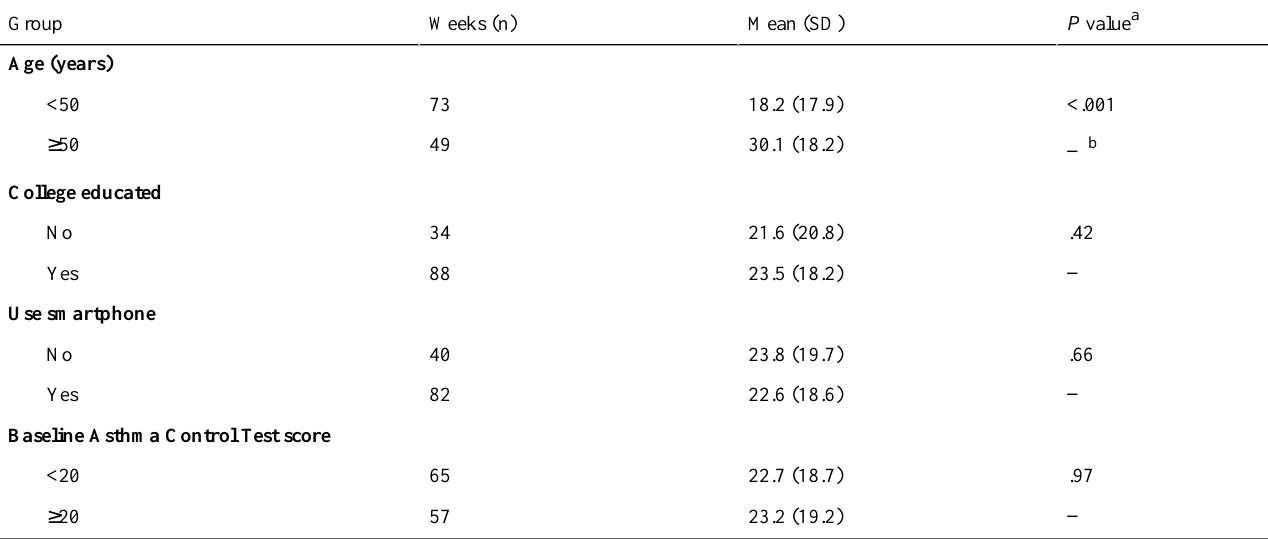
Table 2. Utilization by patient characteristics, indicating the number of weeks with at least one log-in during a 52-week